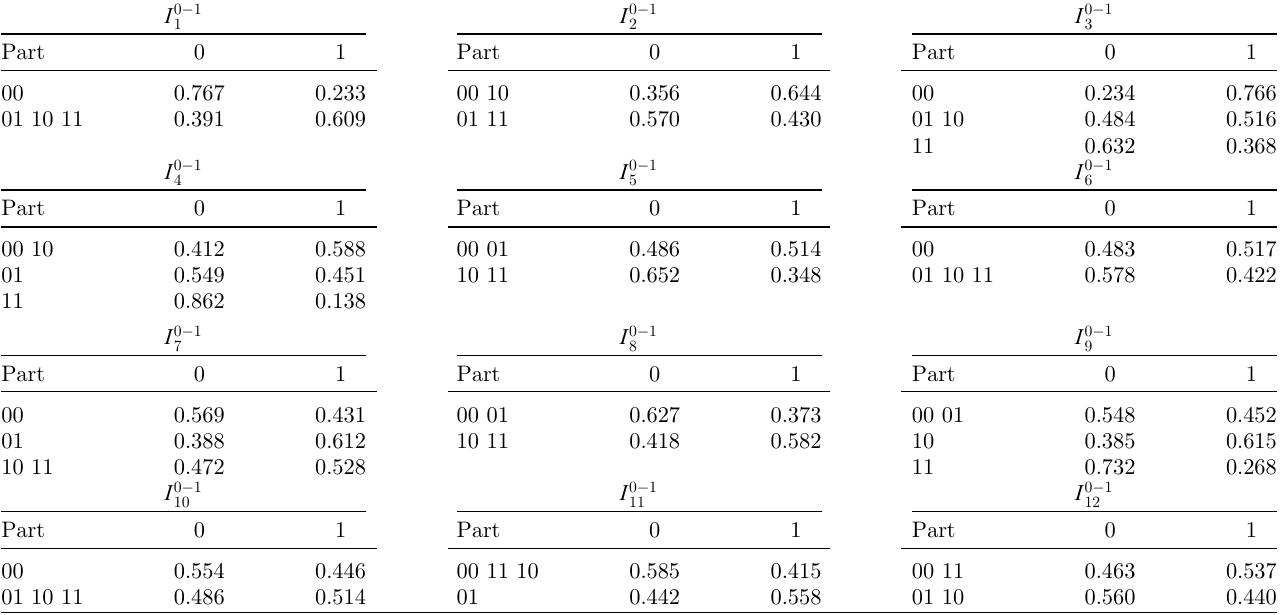
; i = 1, .. . , 12, see equation (5) and Remark i